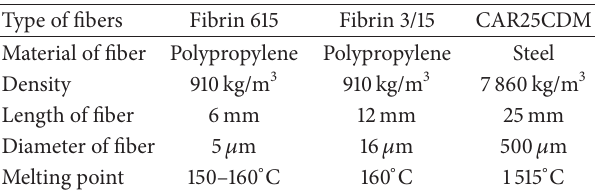
Table 1: Properties of dispersed reinforcement used [10,